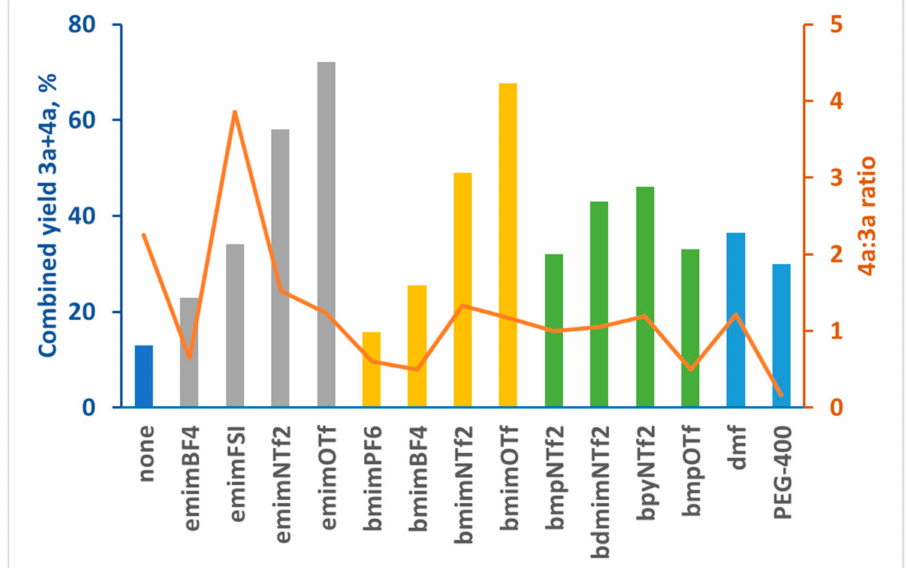
Figure 1. Effect of grinding additives on the electrophilic fluorination of